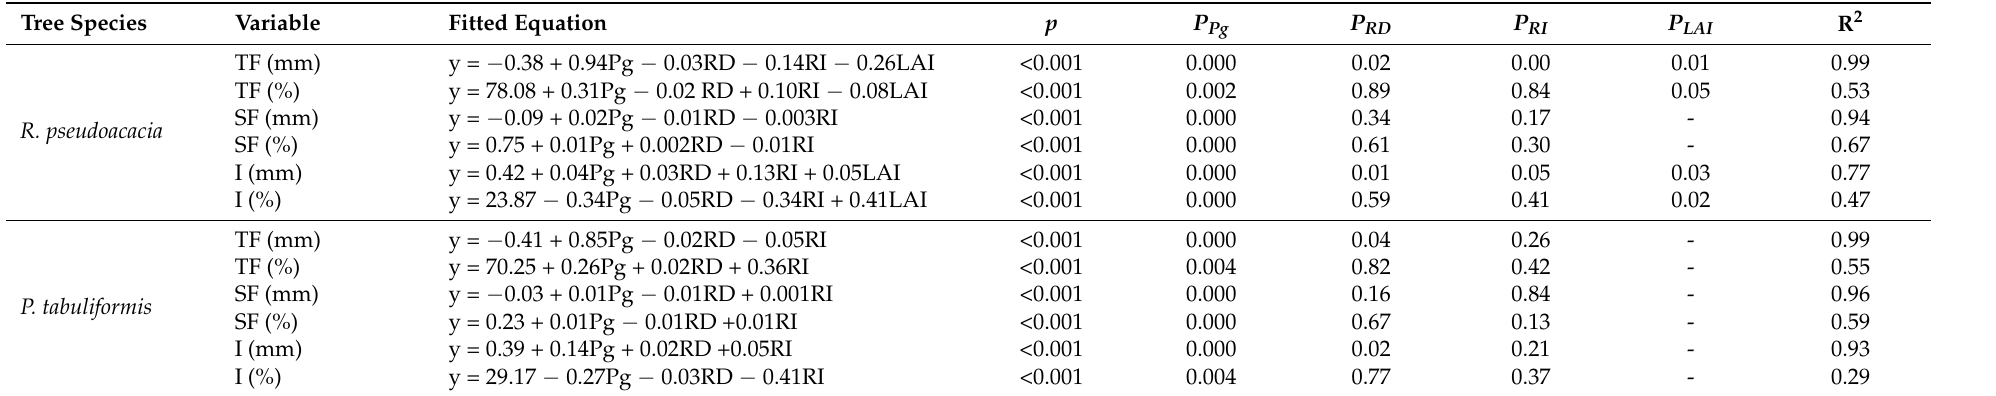
Table 3. Results of multiple line regression analysis of rainfall partitioning components with rainfall characteristics and canopy characteristics for R. pseudoacacia and P. tabuliformis forest stands during the growing season in 2015.